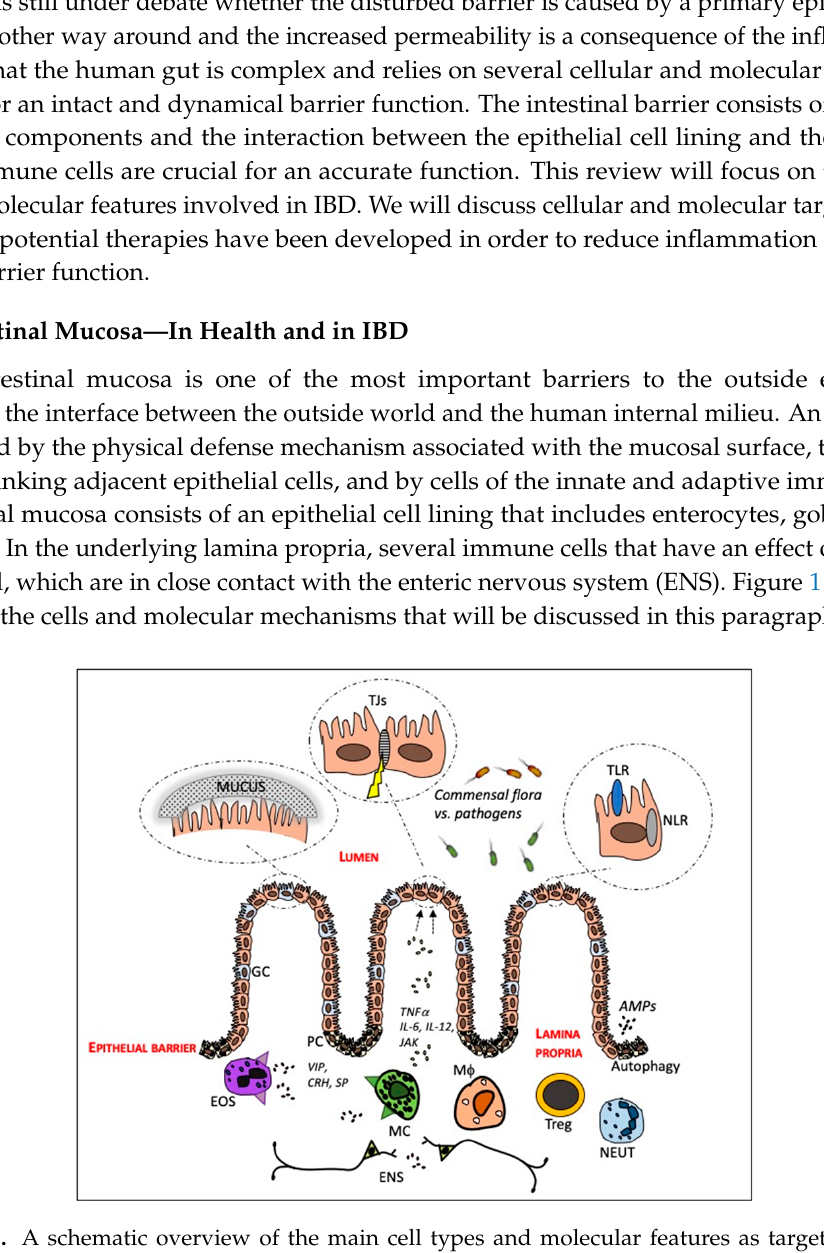
Figure 1. A schematic overview of the main cell types and molecular features as targets related to intestinal barrier function for therapeutic strategies in inflammatory bowel disease. AMPs = antimicrobial peptides, CRH = corticotrophin releasing hormone, ENS = enteric nervous system, EOS = eosinophil, GC = goblet cell, JAK = Janus kinases, M φ = macrophage MC = mast cell, NEUT = neutrophil NLR = nod-like receptor, PC = Paneth cell, SP = substance P, TJs = tight junctions, TLR = toll-like receptor, Treg = regulatory T cell, VIP = vasoactive intestinal polypeptide.